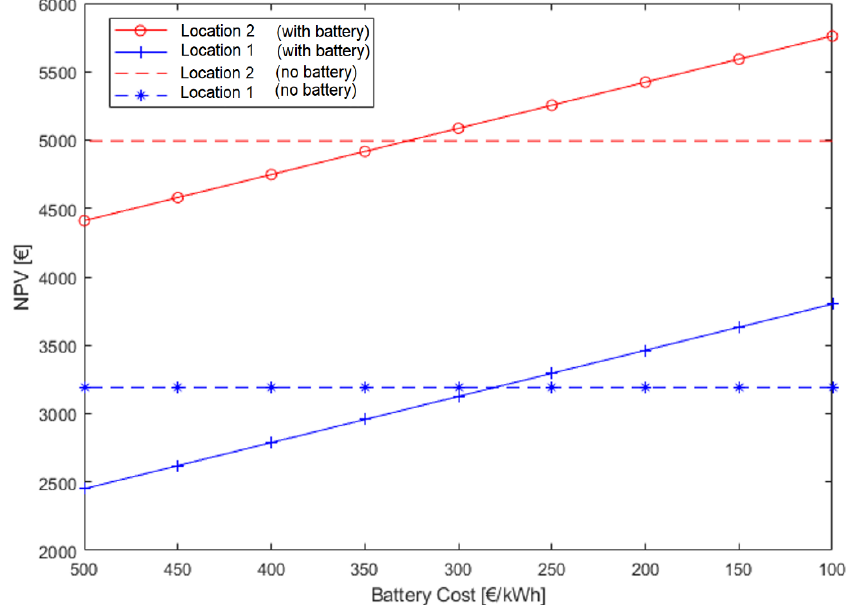
Figure 20. Net Present Value (NPV) (20th year) sensitivity analysis with respect to a variation of the battery cost.